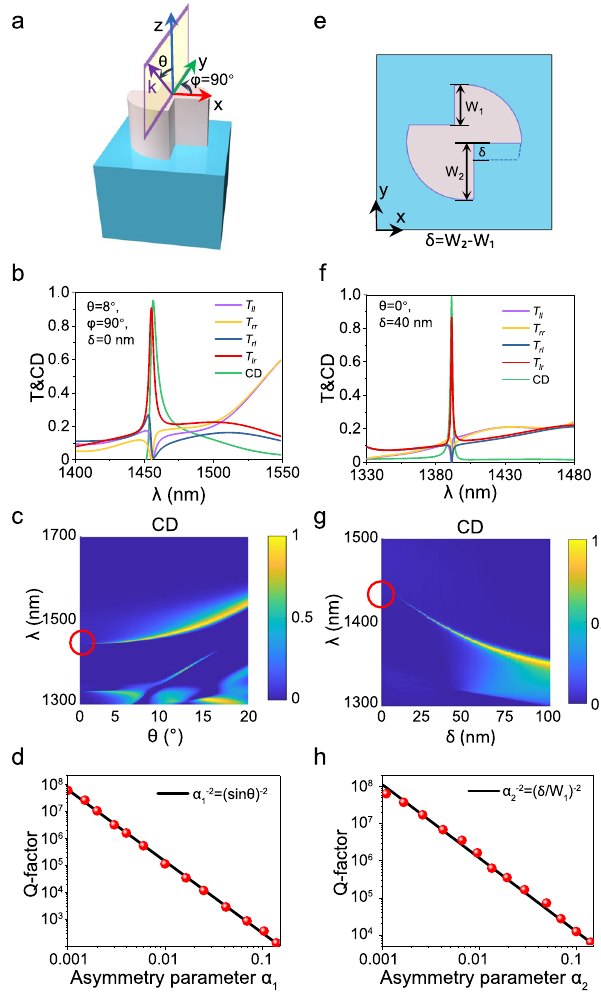
Fig. 2 Proposed implementation of the DSS structure with both the extrinsic and intrinsic planar chirality by transferring the BIC to q-BICs. a , e Schematic of the symmetry-breaking processes that transfer the BIC to planar chiral q-BICs: ( a ) illumination symmetry breaking by varying incident angle θ , ( e ) in-plane geometry symmetry breaking by δ = W 2 -W 1 . b , f Simulated transmission Jones matrix spectra of T ll , T rr , T rl and T lr as well as the CD spectrum of the metasurface with ( b ) the same parameters as Fig. 1d ( δ = 0 nm) under oblique incidence ( θ = 8°, φ = 90°) and with ( f ) an asymmetric structure parameter ( δ = 40 nm) for normal incidences. c , g The evolution of CD spectra by continuous varying ( c ) incident angle θ along the φ = 90° direction and by ( g ) the geometry asymmetry parameter δ . d , h Dependence of the Q-factors of the planar chiral q-BIC mode on the relative asymmetry parameter ( d ) α 1 = sin θ , ( h ) α 2 = δ /W 1 around the chiral q-BIC state. The solid line shows an inverse quadratic fi from the intrinsic 3D chirality with preserved helicity between input and output polarizations, the intrinsic planar chirality is always accompanied by circular conversion dichroism (CCD) and asymmetry transmission (AT) 2,13,60 , as shown in Supplementary Fig. S11, due to the preserved symmetry in the propagation direction. The CCD is produced by the mutual orientation of chiral elements and light transmission direction, and the peak value of CCD is close to 1, which is slightly larger than CD (Supplementary Fig. S12). Perfect unitary circular conversion transmittance T lr and CD can be achieved with a strictly sym- metric background as shown in Supplementary Fig. S13. The existence of a practical SiO 2 substrate introduces a perturbation of